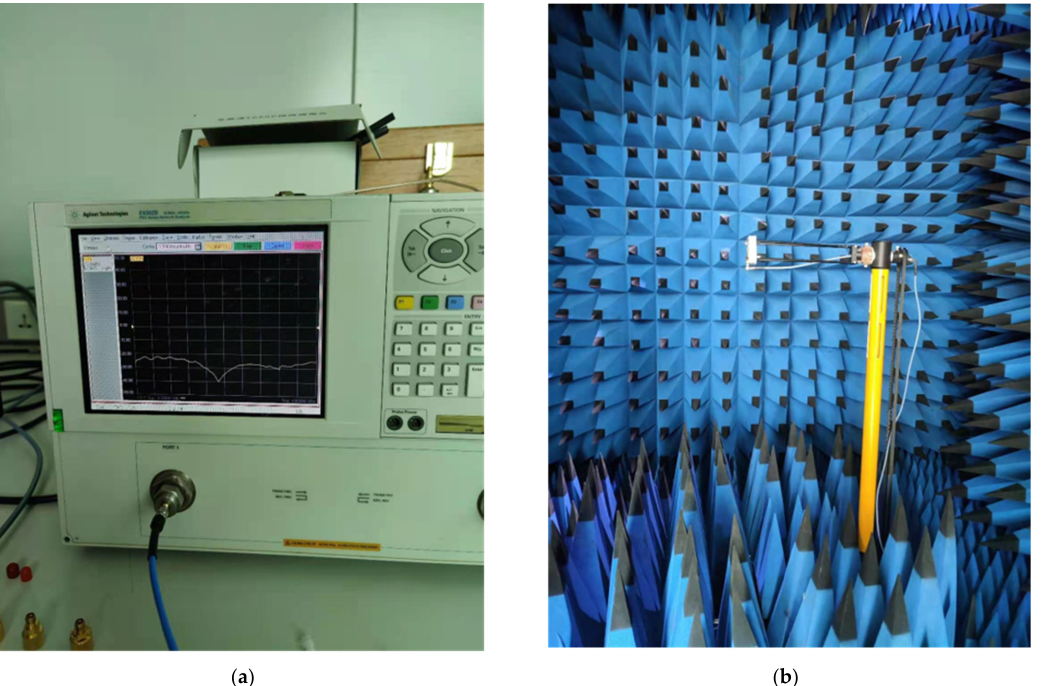
Figure 17. Measurement equipment: ( a ) vector network analyzer for scattering parameters; ( b ) anechoic chamber for radiation performance.